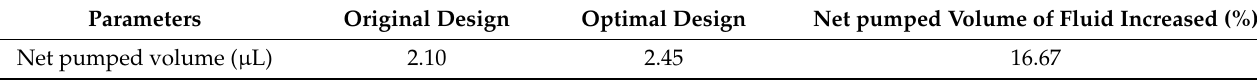
Table 7. Performance comparison between basic model and optimal